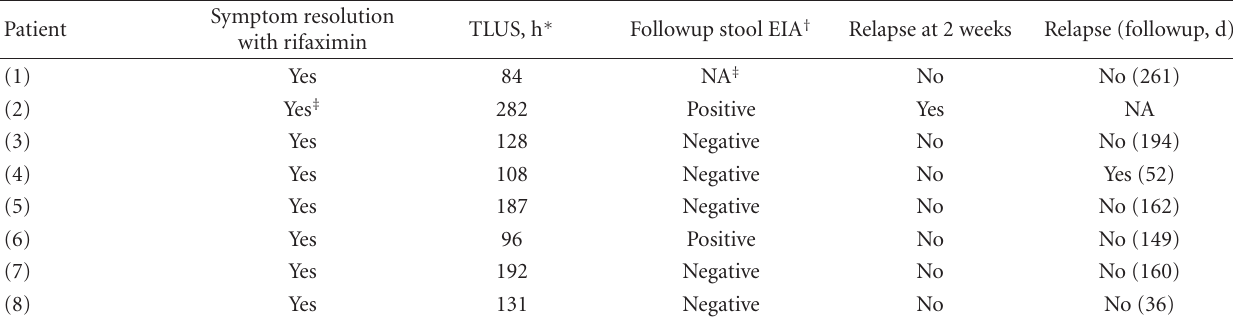
Table 2: CDAD symptom improvement with rifaximin 1200mg/day for 10